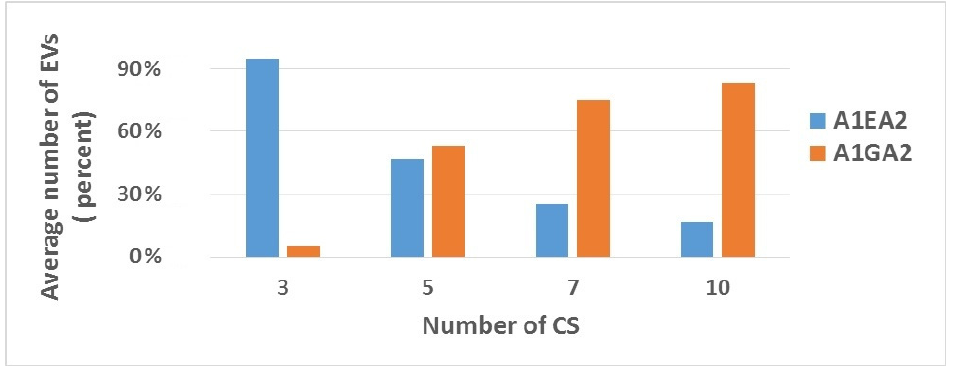
Figure 6. Number of EVs.